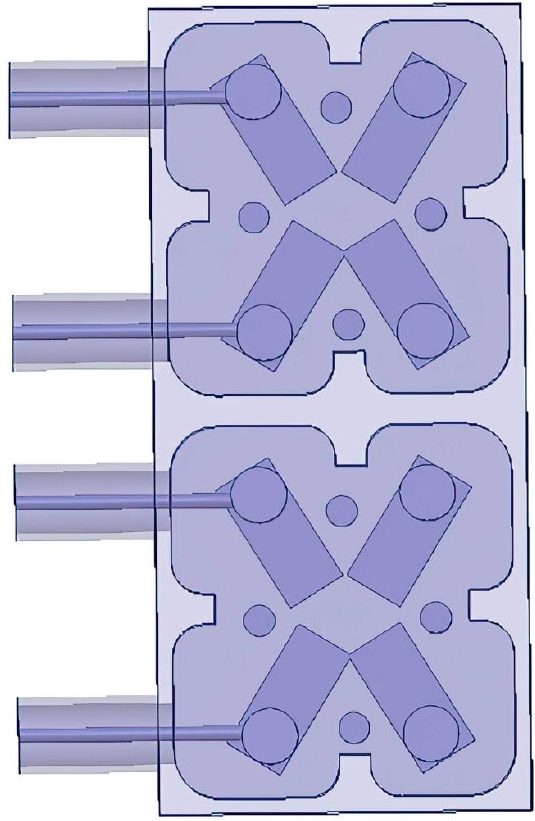
Figure 9. Proposed quadruple-mode band pass filter including tap feeders.